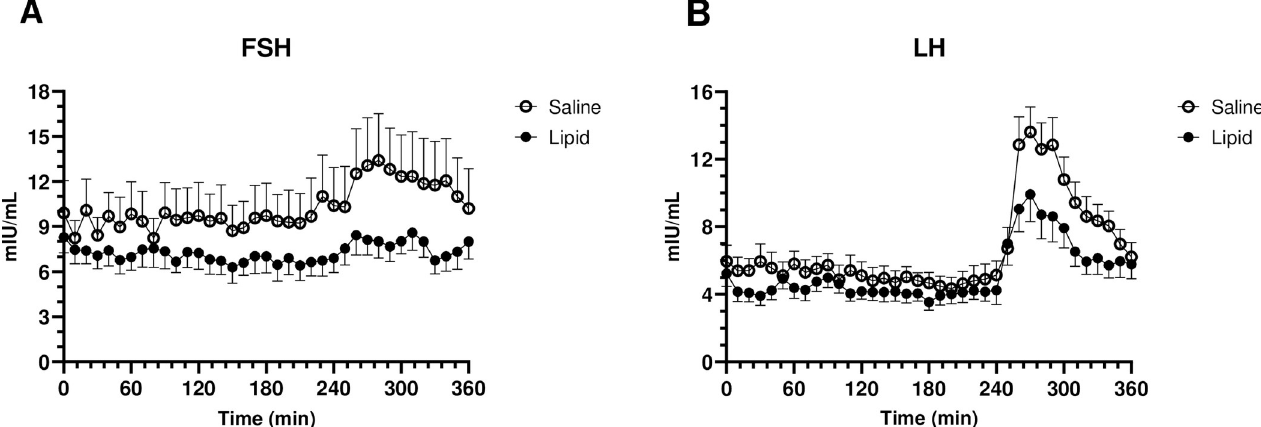
Fig 2. Basal and stimulated gonadotropin levels are decreased in response to acute insulin/lipid infusion. FSH (A) and LH (B) were measured at 10-minute intervals as described [7, 8]. GnRH (75ng/Kg) was administered at 240 min. Values are means ± SEM; n = 12.